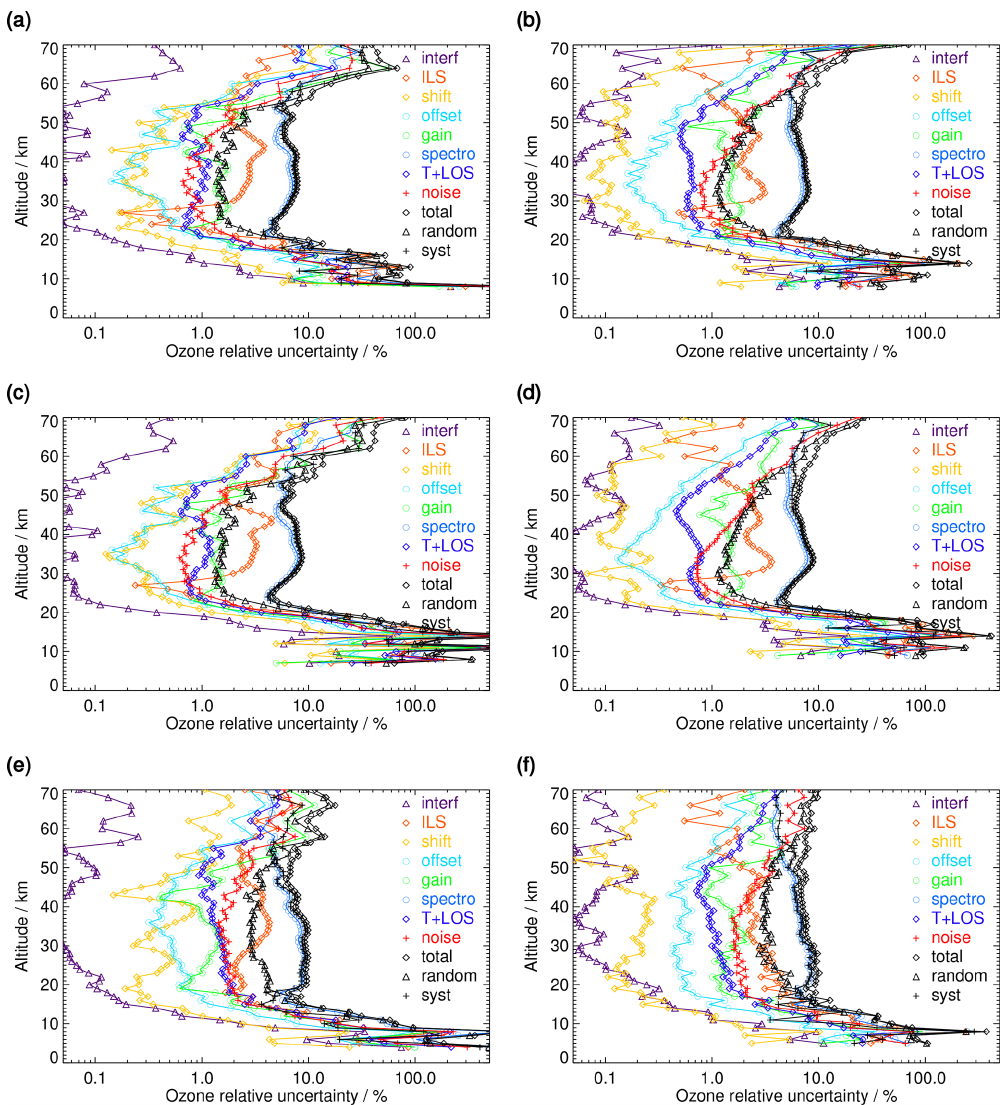
Figure 2. Ozone error budget for FR (a, c, e) and RR (b, d, f) data. Additive and multiplicative errors are shown as relative errors of the respective ozone profiles. All error estimates are 1 σ uncertainties. Error contributions are marked “T+LOS” for the propagated error from the T+LOS retrieval, “noise” for error due to spectral noise, “spectro” for spectroscopic error, “gain” for gain calibration error (MIPAS band A and AB; see text), “shift” for spectral shift error (see text), “ILS” for instrument line shape error (see text), “offset” for error due to spectral offset (see text), and “interf” for the error due to interfering gases. (a, b) Northern midlatitude summer day, (c, d) tropical day, and (e, f) southern polar winter